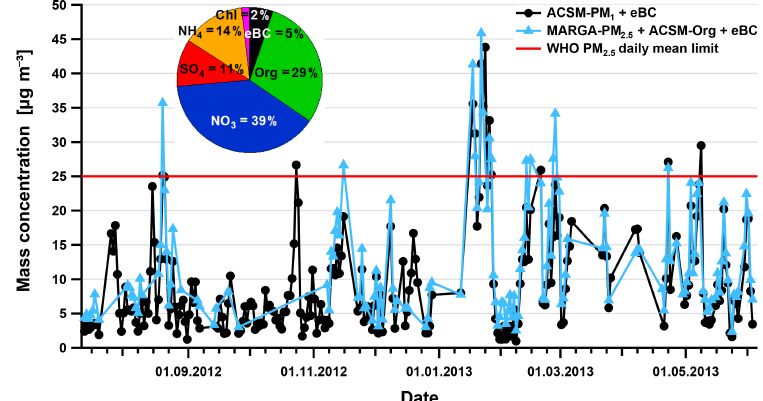
Figure 1. Time series of the daily mean. The black line represents the sum of eBC and all ACSM species, the blue line the sum of eBC, ACSM organics, and all MARGA PM 2 . 5 species. The pie chart shows the fractional abundances of individual eBC and ACSM species averaged over the whole campaign. For the determination of the daily means, missing eBC data were filled with zero values, thus deriving lower concentration